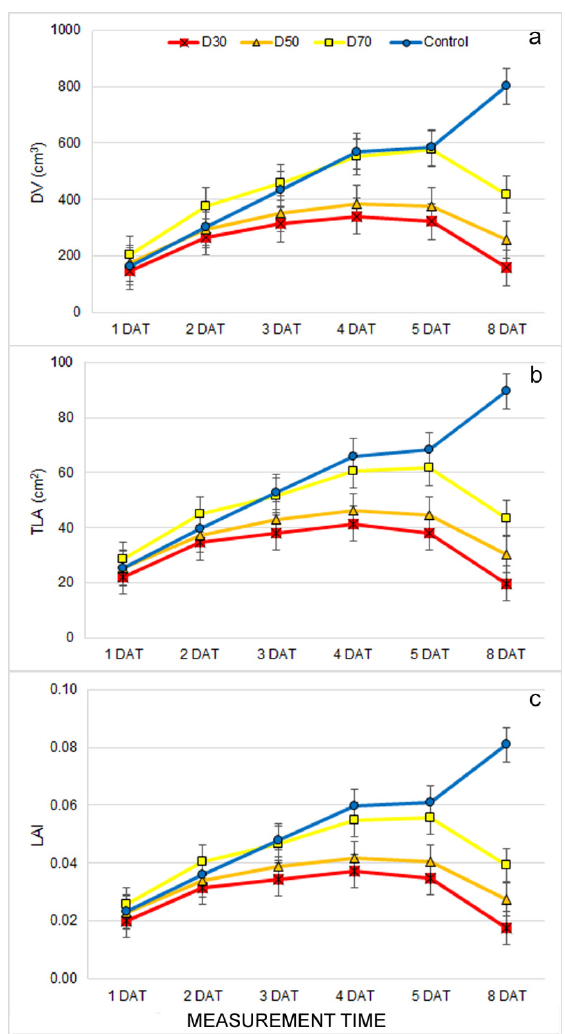
Figure 1. Mean ± double standard error (S.E.) for morphological traits: ( a ) digital volume (DV), ( b ) total leaf area (TLA), and ( c ) leaf area index (LAI) for plants grown under control and drought treatments (D30, D50, and D70) measured from the first to the eighth day after the beginning of treatments (1 DAT–8 DAT).